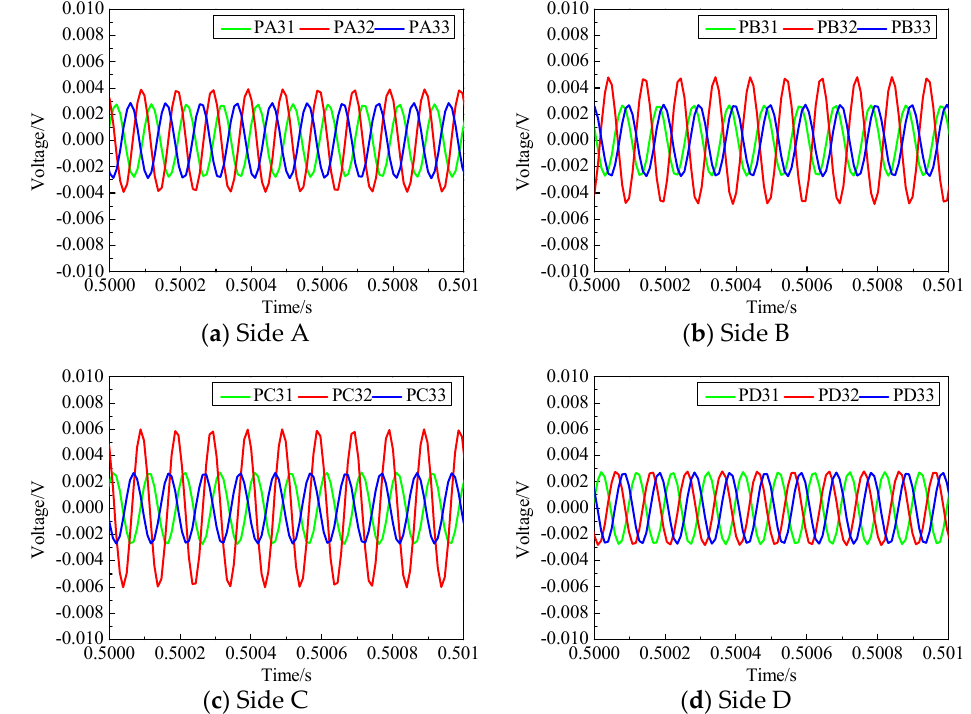
Figure 8. Voltage measurement of the surface-mounted PZT sensors in specimen No. 1.